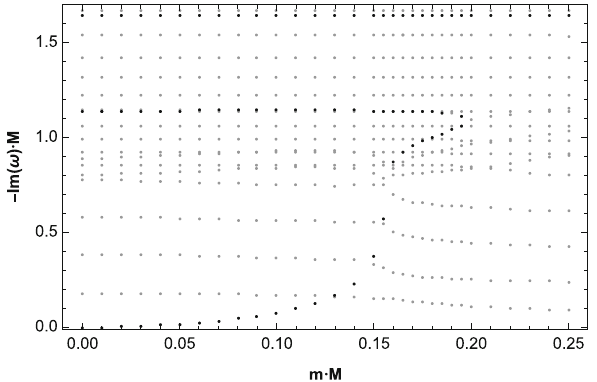
Fig. 8 The behavior of the imaginary part of the quasinormal frequen- cies − Im (ω) M as a function of the scalar field mass mM for different overtone numbers with (cid:5) = 0, M β = 0 . 01, and M 2 (cid:6) = 0 . 04. Black points are for purely imaginary QNFs and gray points for complex QNFs. Here, different colors do not describe the families, except for mM = 0, where the black points correspond to the dS family, while the gray points correspond to the photon sphere family. Then, in order to distinguish the family for mM > 0 it is necessary to connect it with mM = 0, where the different families have been defined